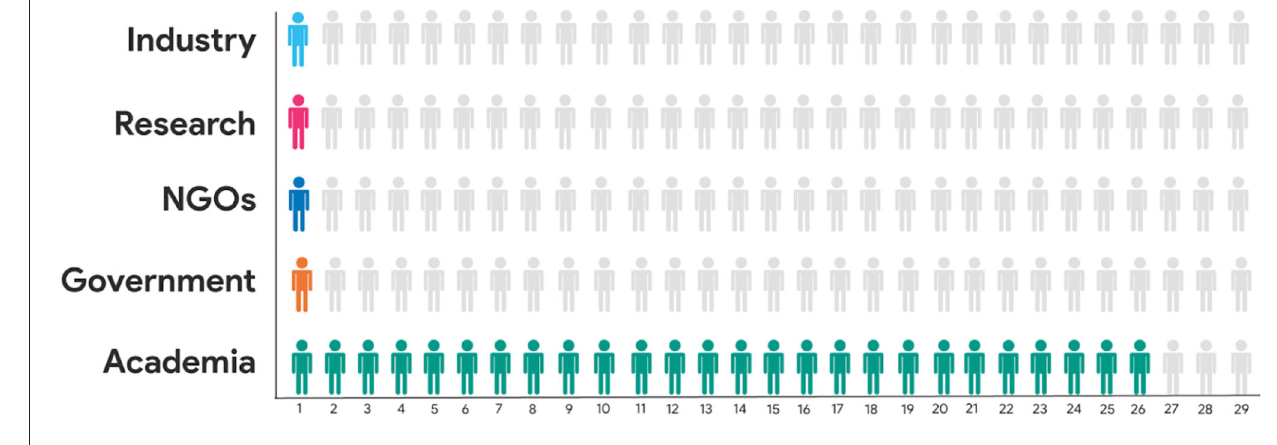
FIGURE 1 | Sectoral distribution of respondents of the initial questionnaire.